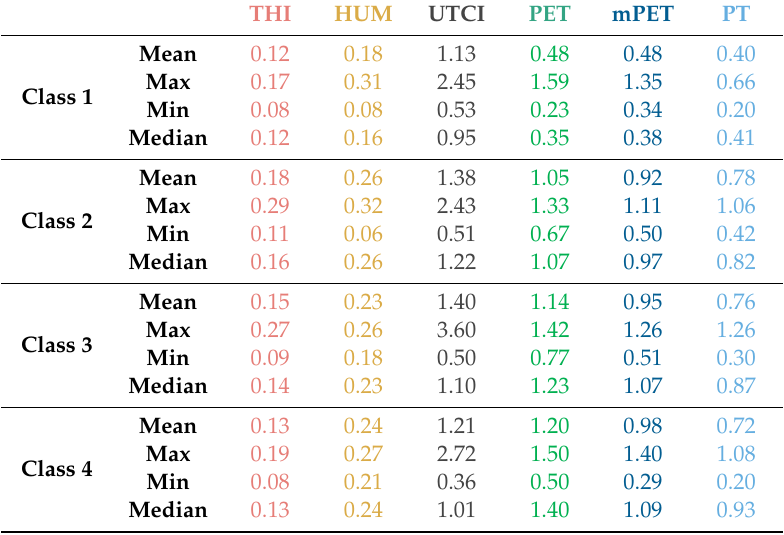
Table 6. Descriptive statistics of the indices’ sensitivity to Air Temperature (T a ) under different Global Radiation (GR) conditions.